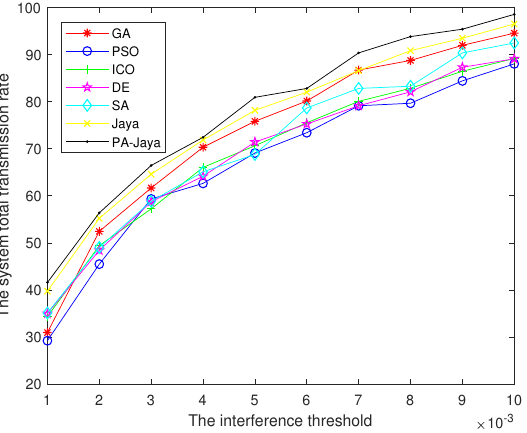
Figure 6. Relationship between the interference threshold and the total system transmission rate.